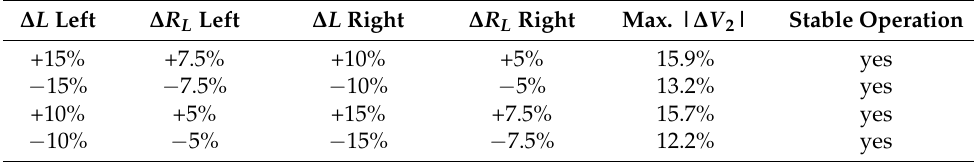
Table 9. Results of robustness analysis against variations of L and R L in Scenario #2.